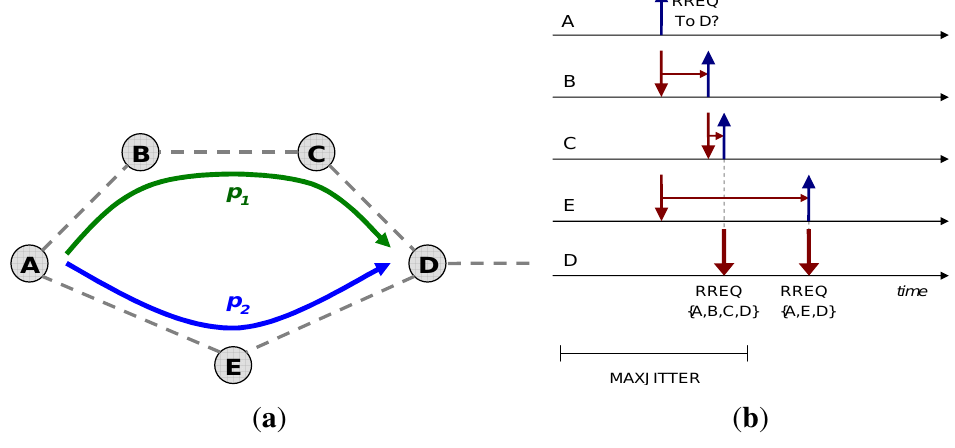
Figure 2. Delay inversion example. Router A tries to broadcast an route request (RREQ) message through the network, through paths p path { A, B, C, D } travels faster than the one through the shorter path { A, E, D } , due to (unfortunate) jittering. ( a ) Topology; ( b ) Example of jitter value assignment for an RREQ from A towards D